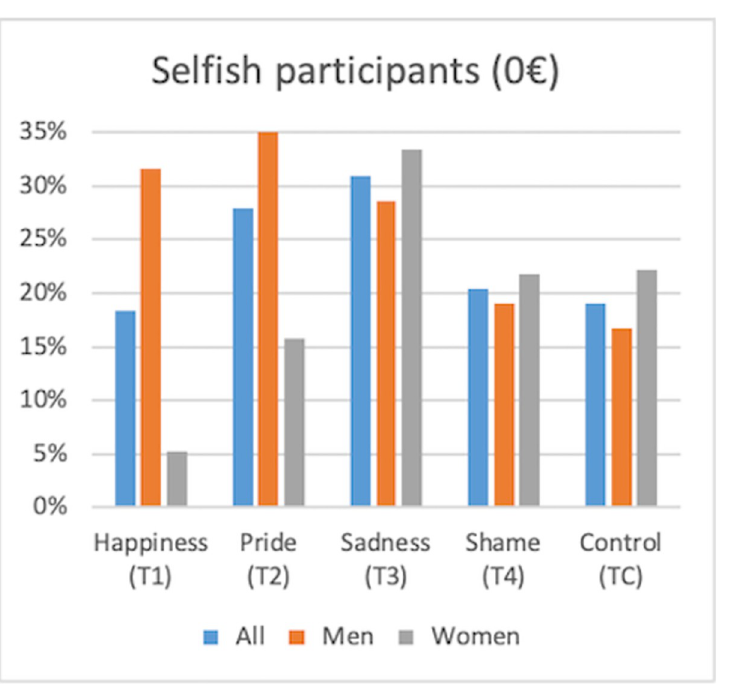
Fig 1. Selfishness and gender effect (by